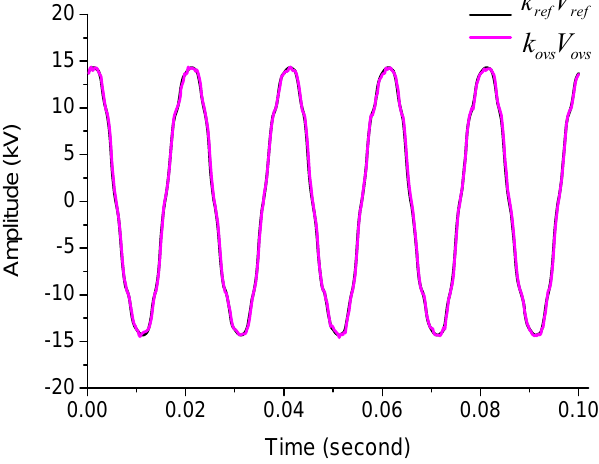
Figure 5. Waveforms of the reference voltage transformer measurement and the OVS system measurement.